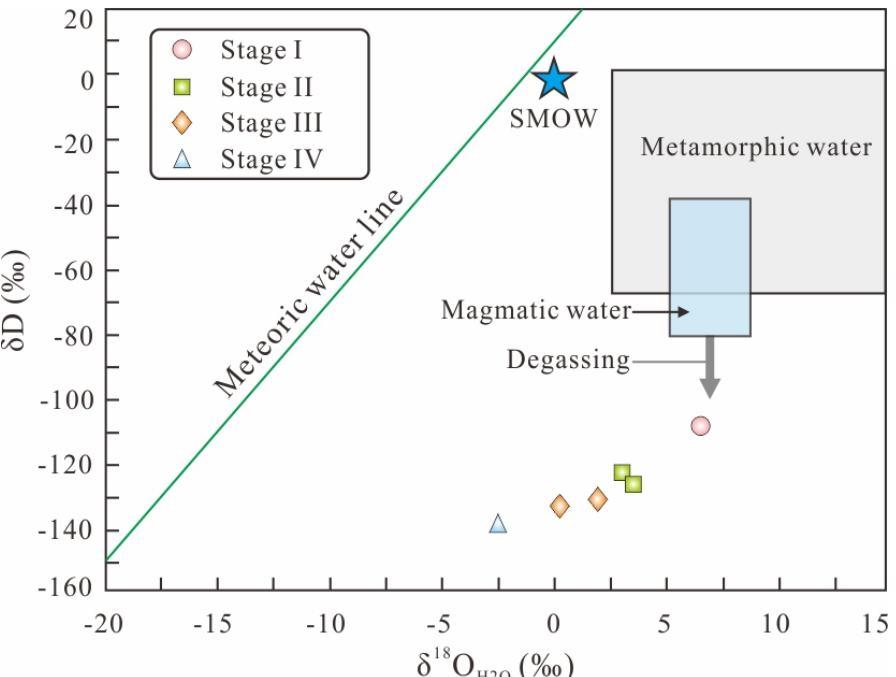
Figure 8. Plot of δ D vs. δ 18 O H for the ore-forming fluids in the Huoluotai Cu (Mo) deposit [33]. 2 O SMOW = Standard Mean Ocean